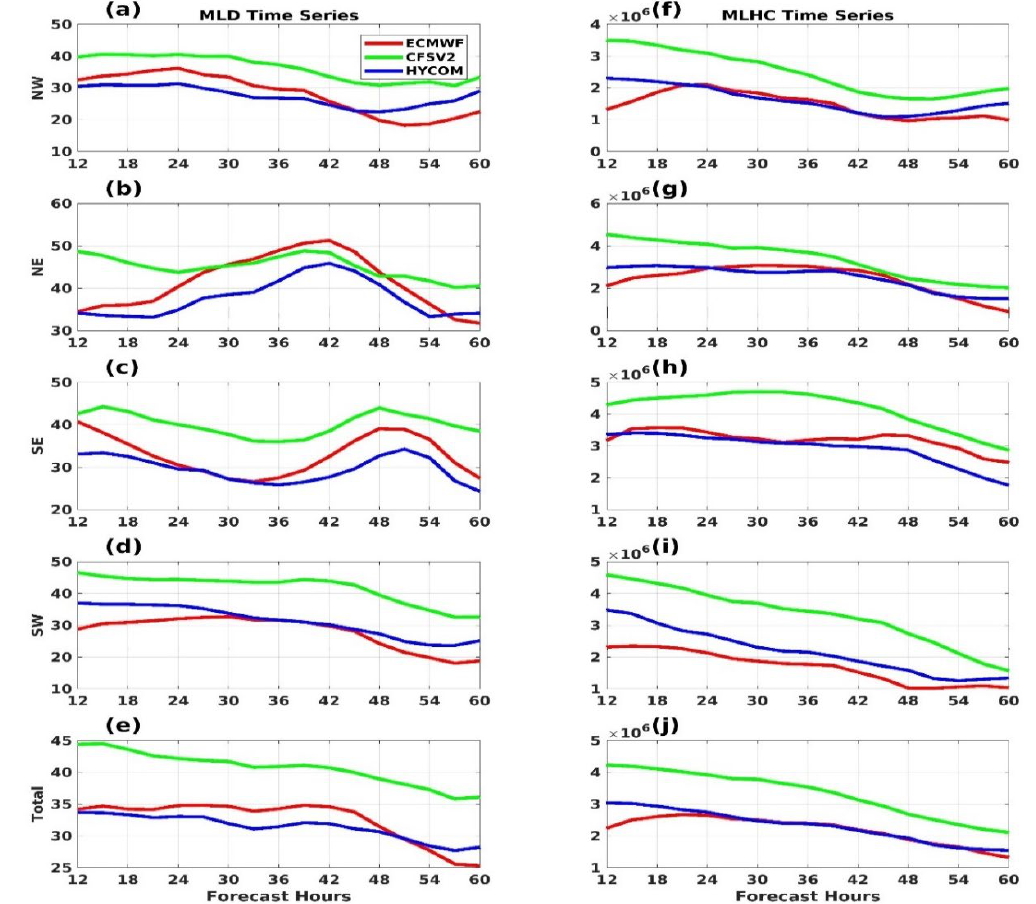
Figure 7. Time series for the quadrant-wise variations in ( a – e ) mixed layer depth (MLD) (m) and ( f – j ) mixed layer heat content (MLHC) (J·kg − 1 ), calculated over the VFB, obtained from all the experiments.